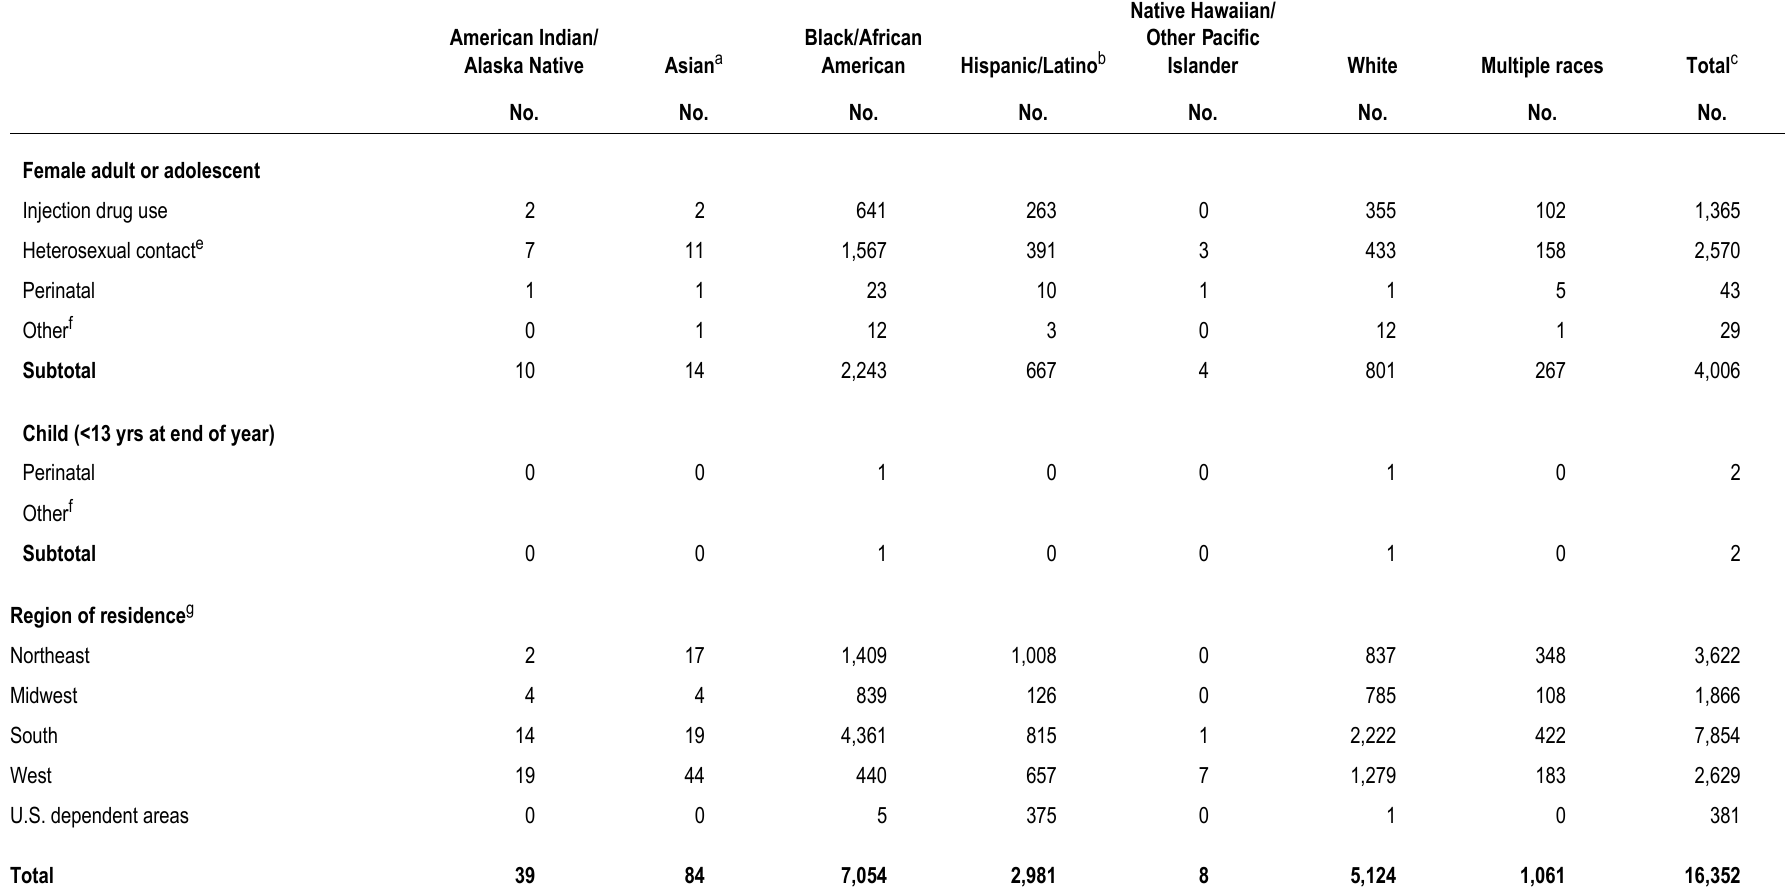
Table 20b. Deaths of persons with diagnosed HIV infection, by race/ethnicity and selected characteristics, 2017—United States and 6 dependent areas